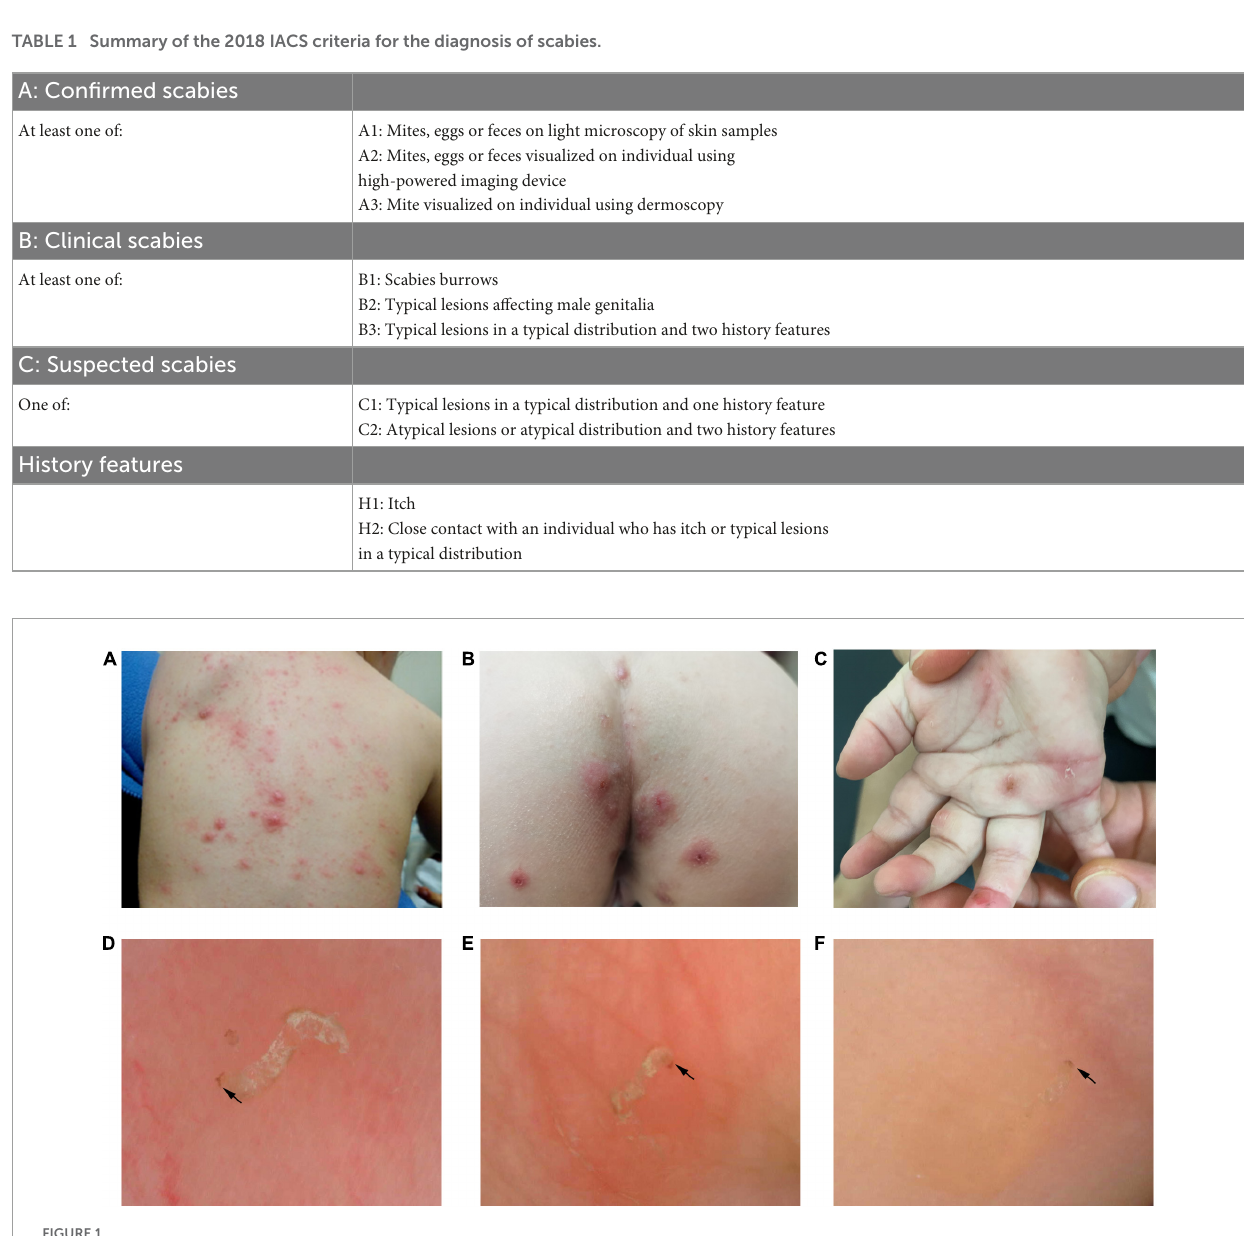
FIGURE1 Panels (A–C) were clinical images. At the end of the curvilinear scaly burrow, the mite itself was seen as a dark triangular structure (black arrow) under dermoscope. Panel (D) was the dermoscopic image of trunk. Panel (E) was the dermoscopic image of external genital. Panel (F) was the dermoscopic image of finger seam.